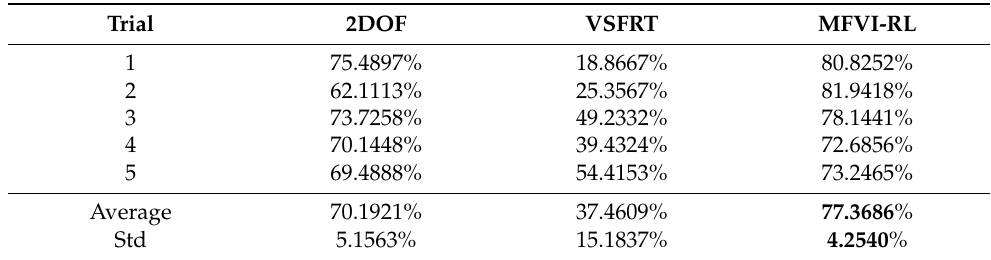
Table 1. 2DOF, VSFRT and MFVI-RL tracking performance score when learning uses closed-loop IO data, measured on fit s core [%]